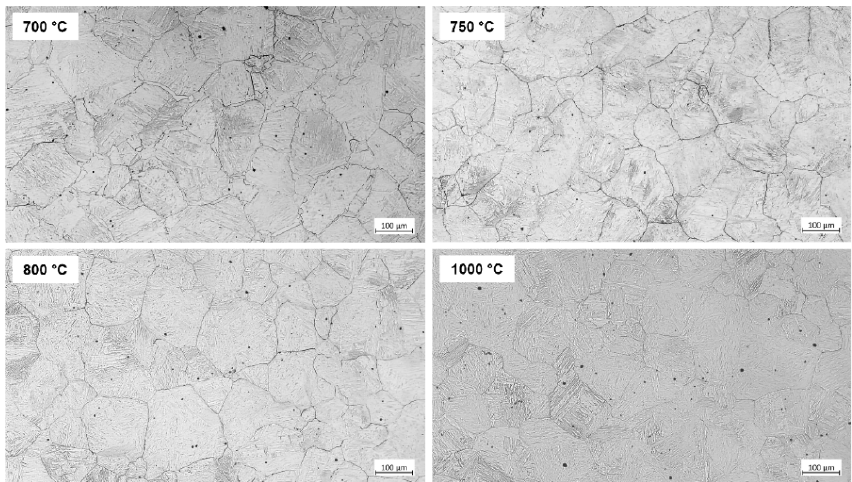
Figure 10. Prior austenite grains from steel A tested with Gleeble at different temperatures without deformation after etching. Size ranging from approx. 100 to 120 µm.